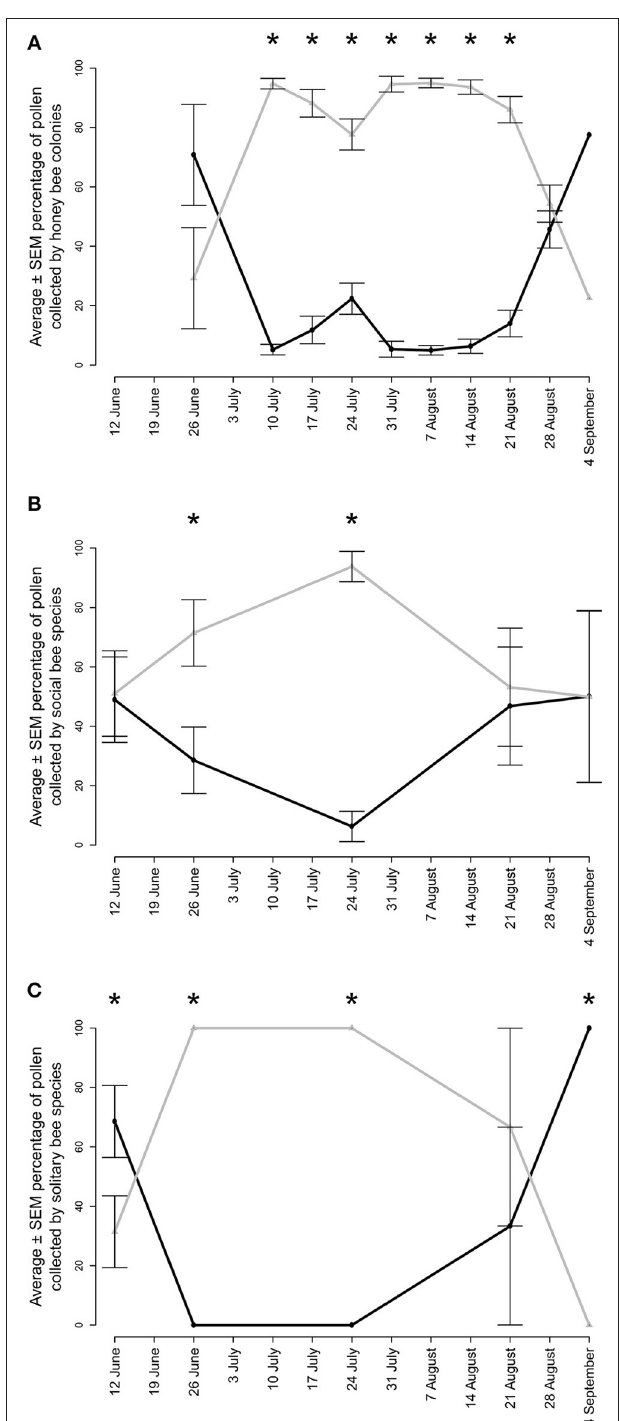
FIGURE 5 | Average ± SEM percentage of pollen collected from non-native (gray lines) and native (black lines) plant genera by (A) honey bee colonies (B) wild social bee species and (C) wild solitary bee species in agricultural landscapes in Gratiot, Isabella, Midland, Saginaw, and Tuscola counties in Michigan. Honey bee hives were placed out in 2017 and 2018 and wild bee specimens were collected in 2018 only. Asterisks indicate significant differences within sampling periods ( p <